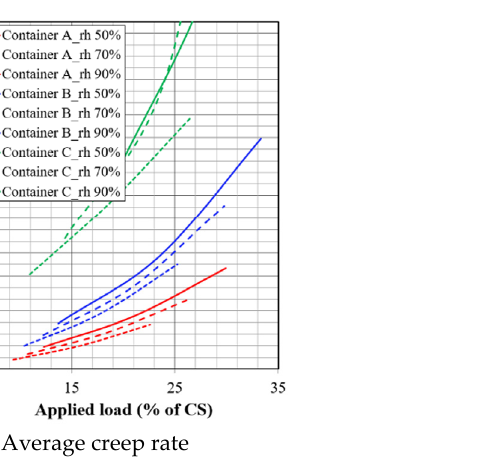
Figure 7. Example of the average creep rate from a nonlinear creep model: Container B, rh = 70%, L o = 0.1652 kN/m, applied load level (% of CS) = 0.1652/2.07 = 7.98%, correction factor = 7.98/(100 − 7.98) = 0.0867 (Tables 4 and 6).